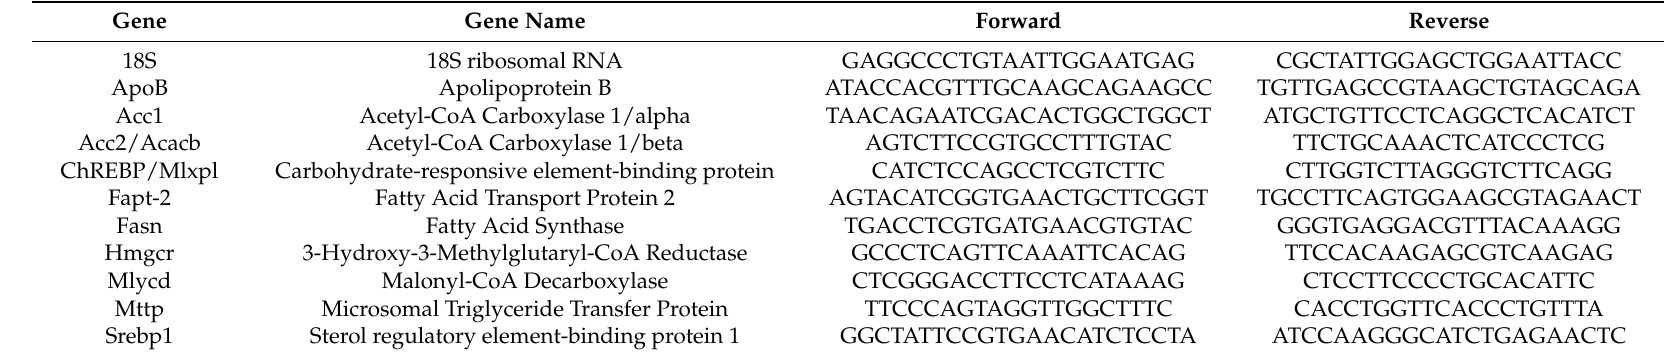
Table 2. Forward and reverse primers used for qRT-PCR 1